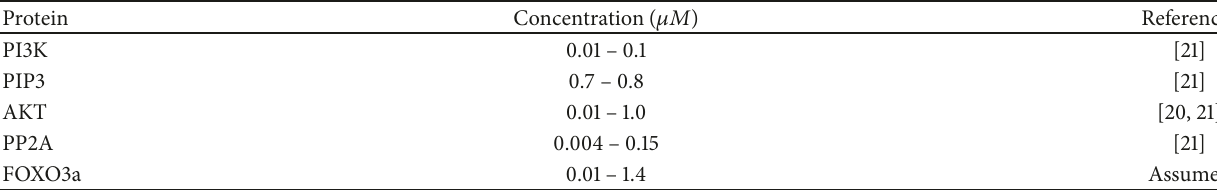
Table 1: Initial concentration of the molecular